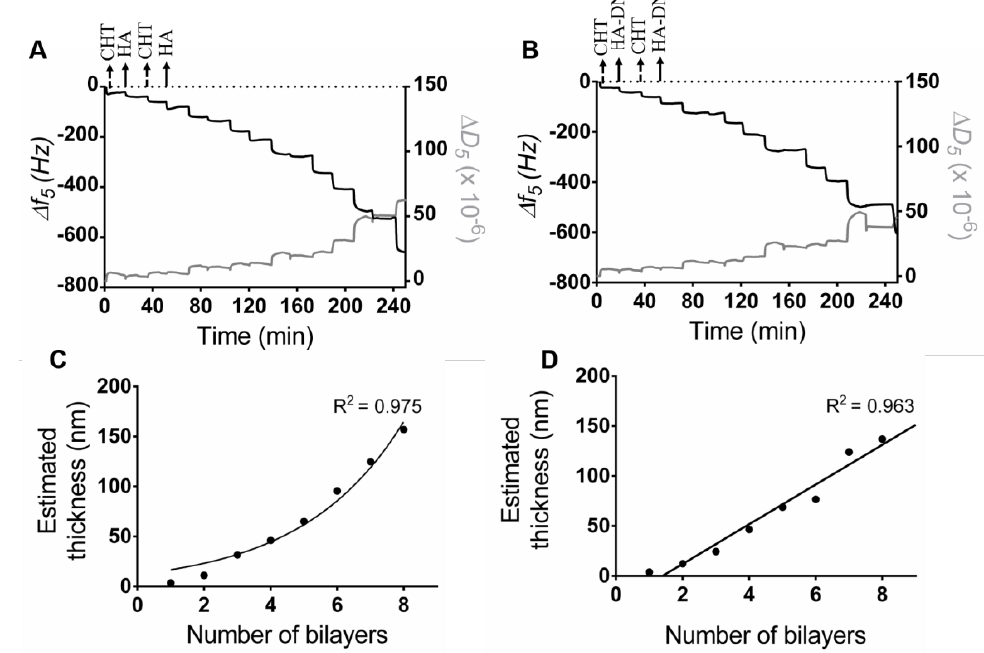
Figure 3. Build-up assemblies of ( A ) CHT and HA, and ( B ) CHT and HA-DN, monitored by quartz crystal microbalance with dissipation (QCM-D). Data shows the normalized frequency (Δ f ) and dissipation (Δ D ) variations at the fifth overtone as a function of the time. Cumulative thickness evolution of the ( C ) CHT/HA and ( D ) CHT/HA-DN multilayer systems as a function of the number of deposition bilayers (Voigt model).